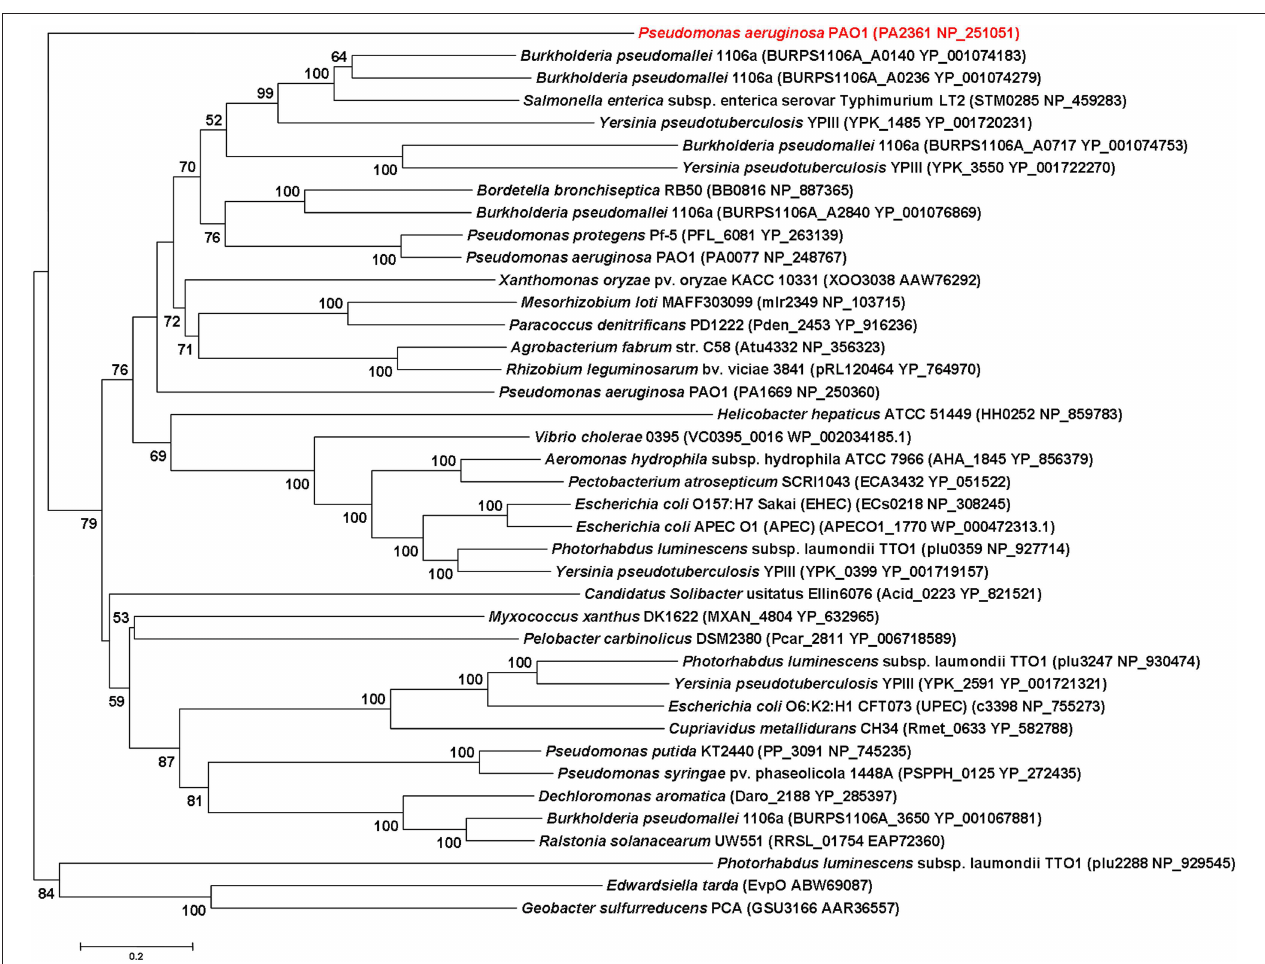
FIGURE 2 | Evolutionary relationships of 40 IcmF orthologues of various bacterial species. Tree construction and other details are given in the Materials and Methods. The scale bar indicates 0.2 substitutions per site.